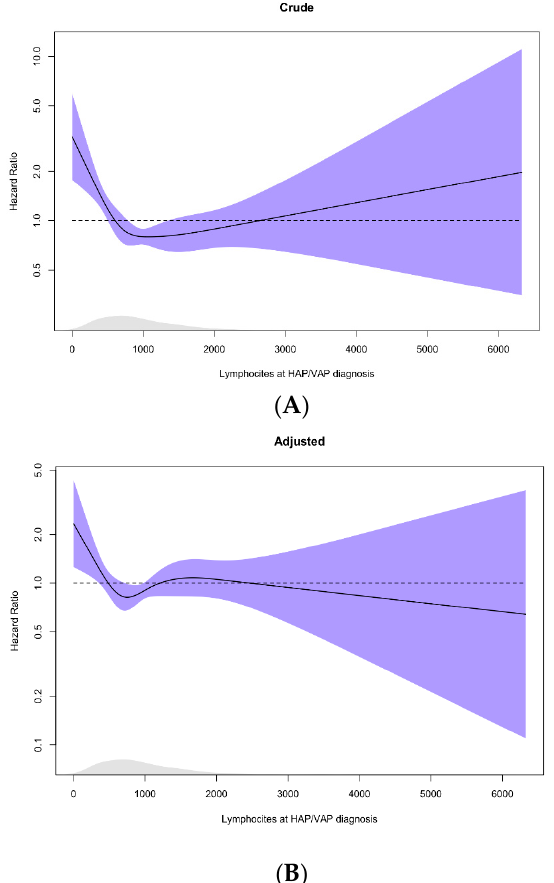
Figure 3. ( A ) Crude and ( B ) adjusted effect of lymphocytes on 90-day mortality. The curves were estimated in Cox proportional hazards models using restricted cubic splines with four degrees of freedom (df); 95% CI in shaded area, Rug density of lymphocytes distribution at the bottom. Adjusted for age, liver, cardiovascular and respiratory chronic diseases, systemic steroids at ICU-AP diagnosis, and SOFA at ICU-AP diagnosis; p for nonlinearity, p -value crude: < 0.001, p -value adjusted: 0.0315.